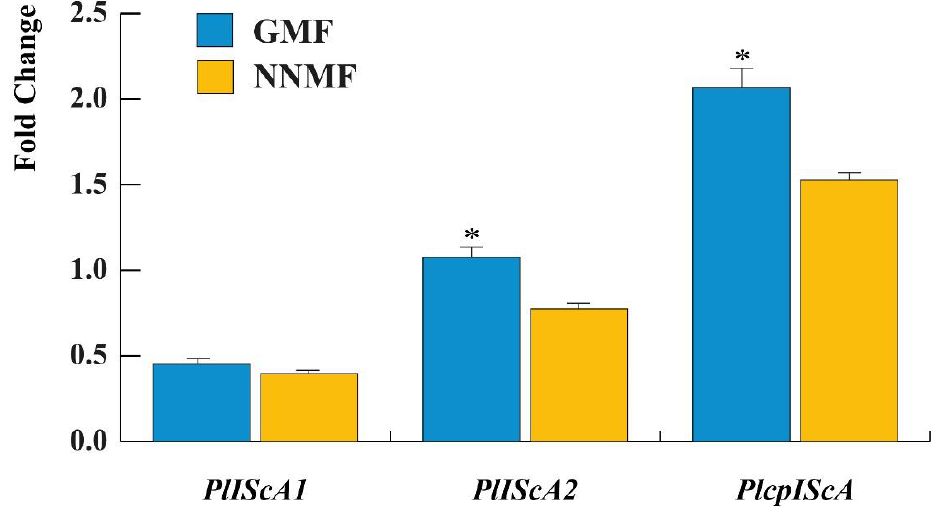
Figure 10. Gene expression of some MagR gene homologs in Lima bean: PlIScA1 , PlIScA2 and PlcpIScA . Data are expressed as a fold change with respect to the housekeeping gene UBP6 . Metric bars indicate standard deviation, asterisk indicates significant ( p < 0.05) differences between GMF and NNMF.